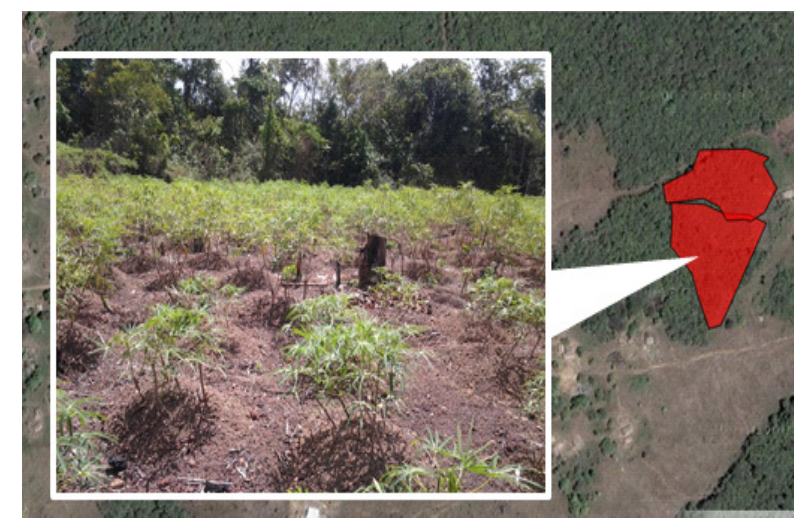
Figure 2. Mobile phones were used to record the points on the boundary of the farmland, capturing the area and shape of the farm; the resulting polygons are now visualized in Google Maps